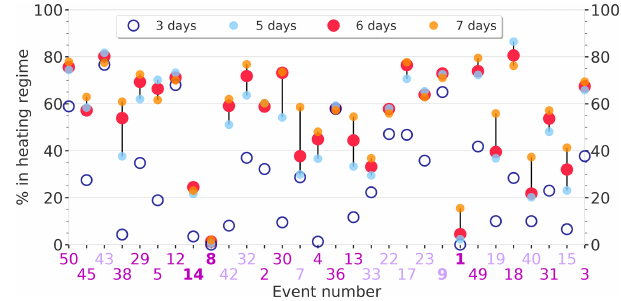
Figure 9. Percentages of blocking air parcels in the heating regime shown per Ural event for back trajectories during 3 (blue), 5 (light blue), 6 (pink) and 7 (orange) days before their arrival into the blocking region. The percentages for 5 and 7 days are connected with a black vertical line. Event numbers refer to event ranking, here sorted by time, where magenta numbers refer to pure Ural events (Ural cluster), light purple to the mixed cluster and bold numbers (event 14 and 8, event 9 and 1) refer to events associated with the same